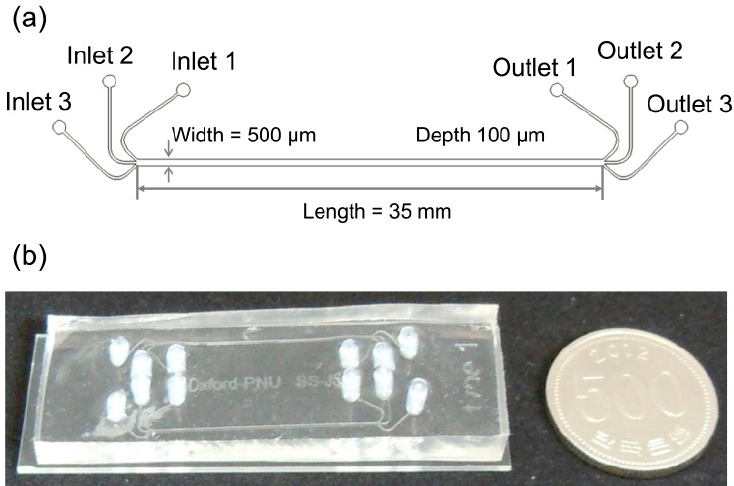
Figure 3. Design and fabrication of the microfluidic channel: ( a ) detailed sizes of the microfluidic channel; ( b ) picture of the fabricated microfluidic channel.